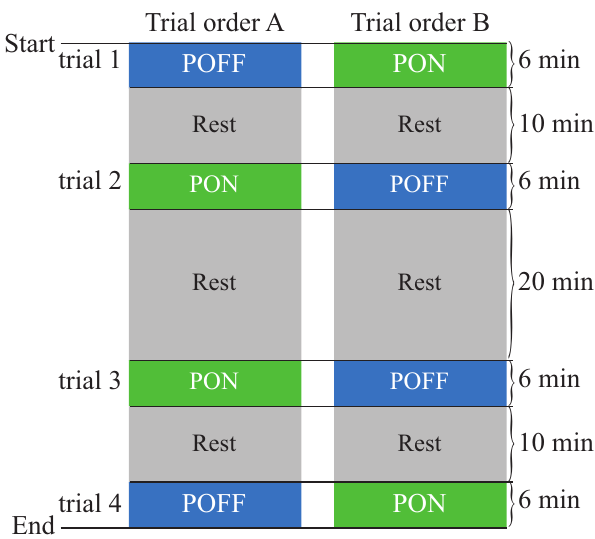
Figure 5. Protocol of each experimental day. PON, powered on; POFF, powered